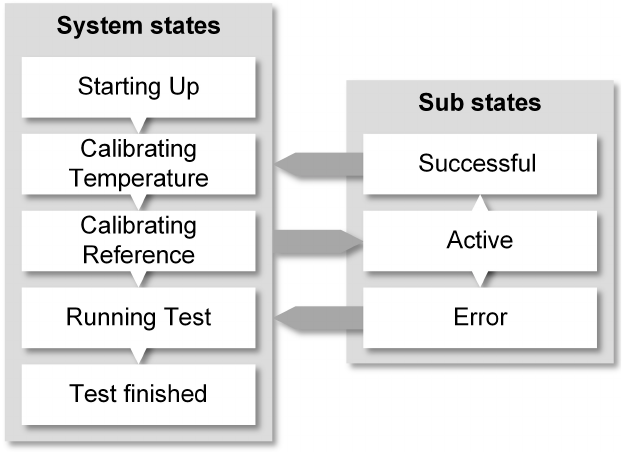
Figure 13. Discrete system states of the firmware.